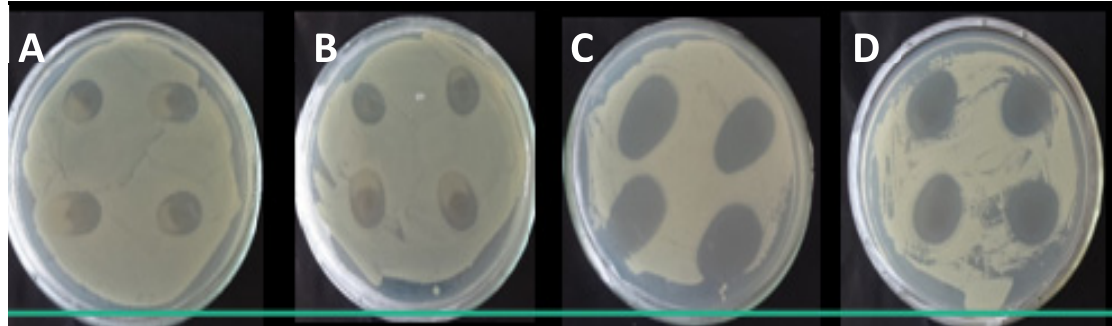
Figure 6. The antibacterial activity of nanocomposite by disc diffusion method: ( A )—GE film; ( B )—GEDA film; ( C )—GEP4 film, and ( D )—GEP4DA film. For each film, four samples were used to determine inhibition halo. The inhibition zone was calculated through the mean of the halo values obtained.